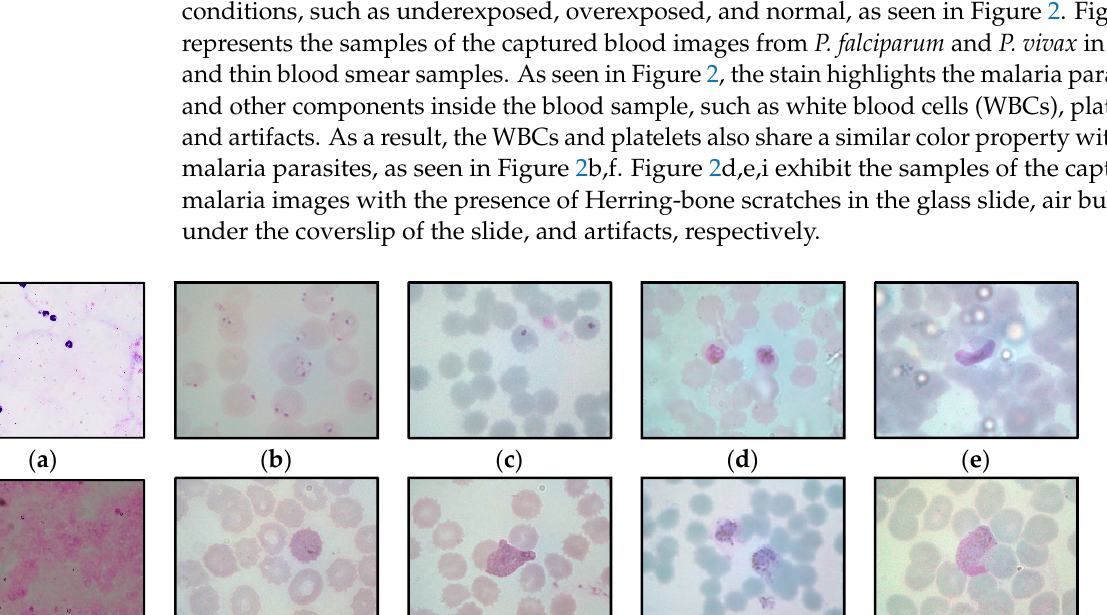
Figure 1. OLYMPUS BX41 digital microscope.